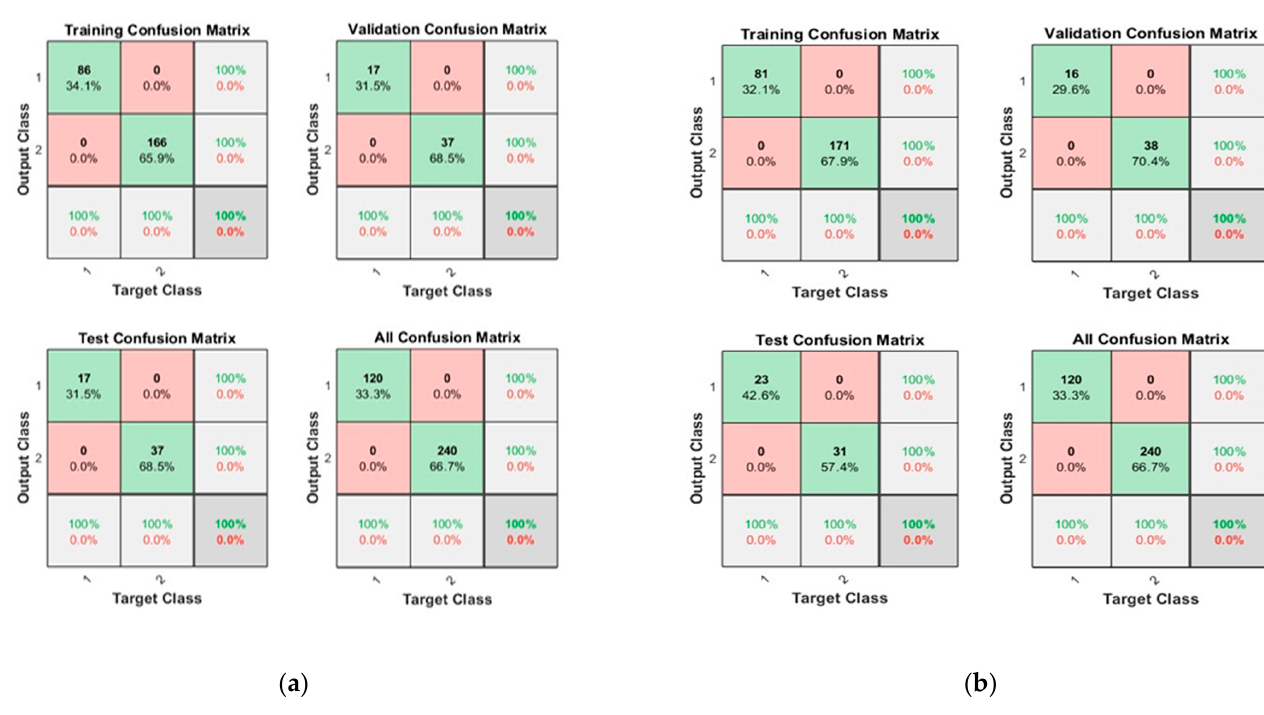
Figure 7. Confusion matrices of Dataset-1, where class label 1 shows Normal operating conditions and class label 2 shows the Leak operating conditions of the pipeline using ( a ) 10 Neurons and ( b ) 50 Neurons.